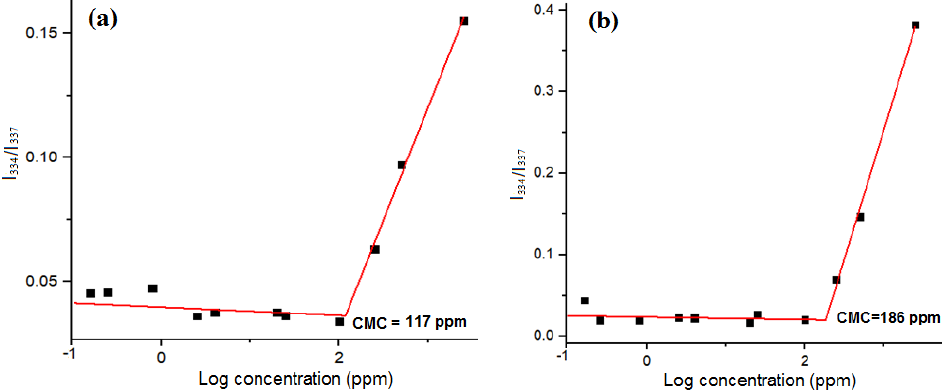
Figure 4. Fluorescence intensity ratio of bands (I1 / I3 of pyrene as a function of the logarithm of the copolymer concentration that indicated CMC values with the intersection of the tangents: ( a ) GP-F127 and ( b ) GP-F87 .